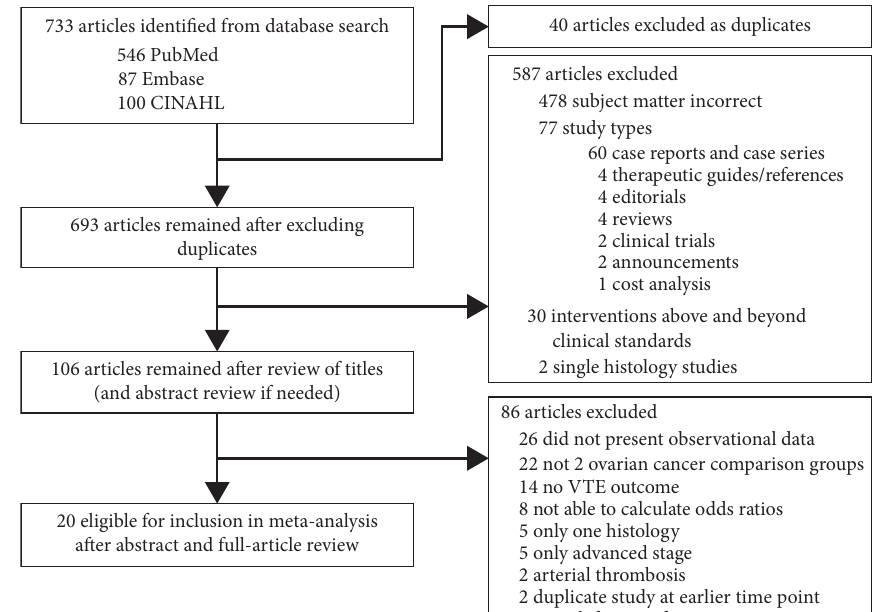
Figure 1: Selection of studies in the meta-analysis. This figure shows the selection criteria and process. 733 articles were identified and ultimately 20 articles were included in the